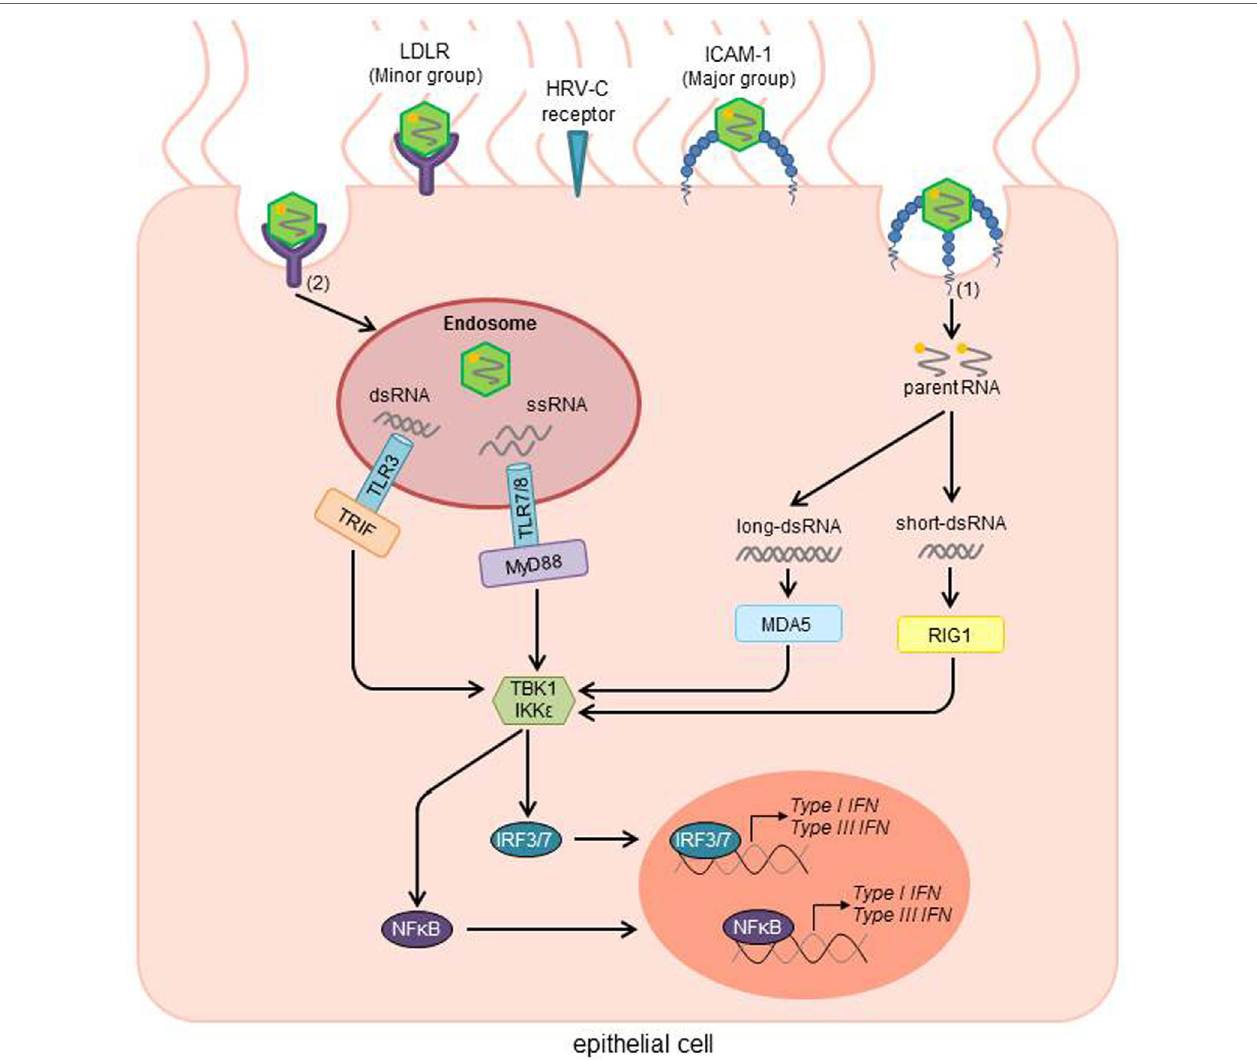
FiGURe 1 | HRV activated signal transduction pathways of the innate immune response after infection of airway epithelial cells. Depending on the receptor type, virus uptake occurs directly without a need for any cellular machinery [Major group; (1)] or via clathrin-dependent endocytosis [Minor group; (2)]. After uncoating, viral RNA activates cytosolic and endosomic pattern recognition molecules (PRMs). While the retinoid acid-inducible gene 1 (RIG1) recognizes short viral dsRNA, the melanoma differentiation-associated gene 5 (MDA5) binds to long dsRNA. In the endosome, viral dsRNA and ssRNA are recognized by the Toll-Like receptors TLR3 and TLR7/8, respectively. After recognition of the viral RNA, TLR7/8 then stimulates the adaptor protein myeloid differentiation factor 88 (MyD88), whereas TLR3 activates the Toll/IL-1 receptor domain-containing adaptor inducing IFN β (TRIF). In further steps, TRIF, MyD88, MDA5, and RIG1 activate the TANK-binding kinase-1 (TBK1) and/or the inducible I κ B kinase (IKK). Those factors subsequently induce the interferon regulatory factors 3 and 7 (IRF3/7), as well as NF κ B as transcription factors for type I and III IFNs. HRV, human rhinovirus; ICAM-1, intercellular adhesion molecule 1; LDLR, low-density-lipoprotein receptor; RNA, ribonucleic acid; ssRNA, single-stranded RNA; dsRNA, double-stranded RNA; IFN, interferon [adapted from Ref. (26, 55)].